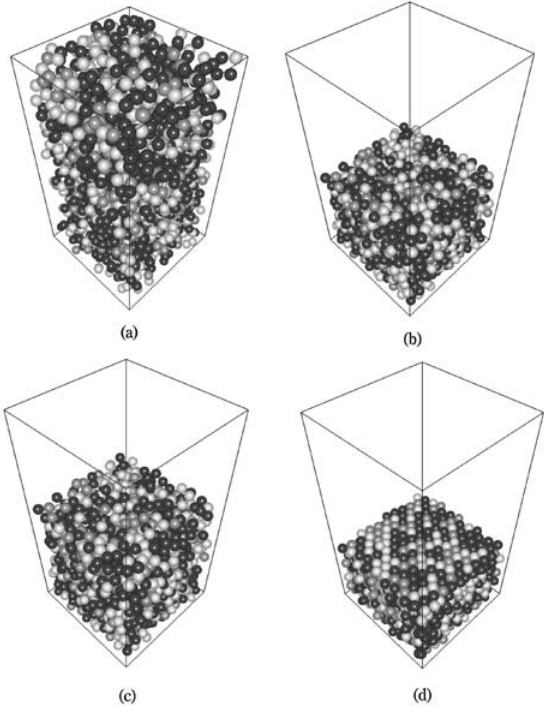
Fig. 1 Snapshots of system: (a). Initial random configuration, (b). Poured assembly ( ν＝ 0.568), (c). Configuration after applying one tap, and (d). Final configuration at 1000 taps. Note that particles are shaded only for the purpose of